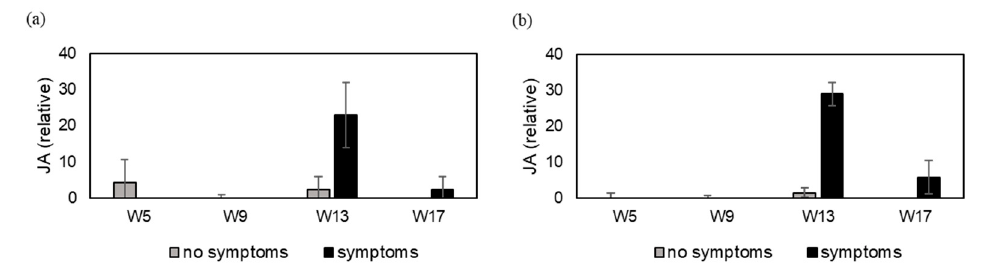
Figure 4. Jasmonic acid (JA) levels on the pot azalea cultivars ‘Michelle Marie’ ( a ) and ‘Leonardo’ ( b ). Plants showing symptoms and plants without symptoms of infestation by Polyphagotarsonemus latus were sampled separately. Data are means ± SD ( n = 3).